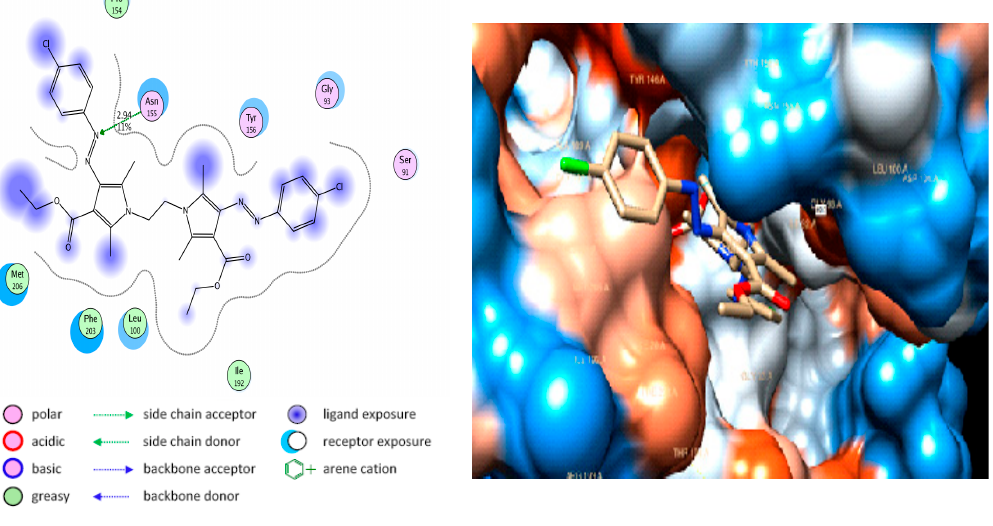
Figure 4. Docking of compound 5d into E. coli Enoyl reductase Enzyme (PDB ID: 1LXC) showing hydrogen bond with Asn155.